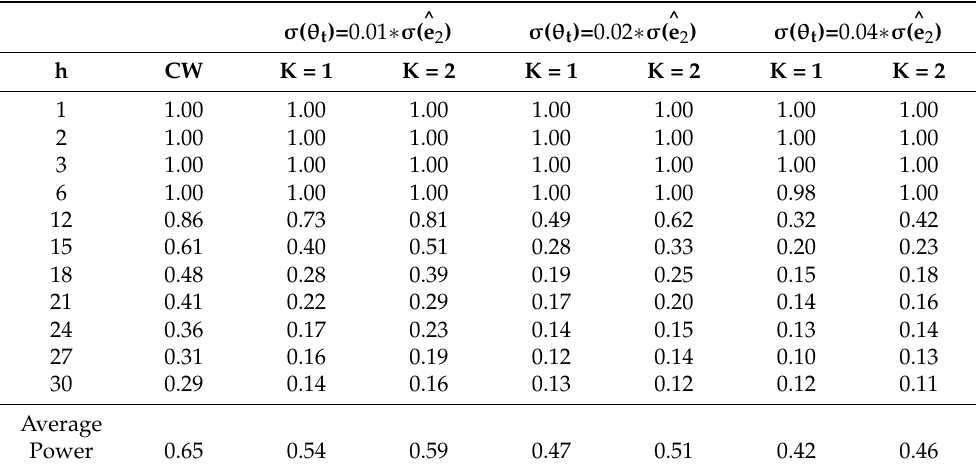
Table 9. Power comparisons between CW and WCW tests with nominal size of 10%, considering DGP2 and a large sample.